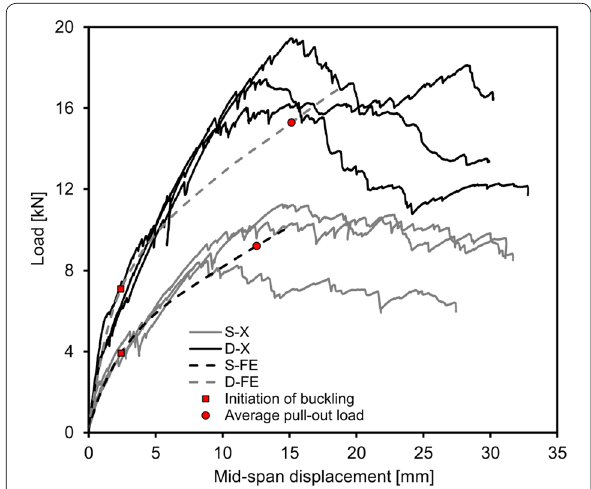
Fig. 17 Comparison of load versus mid-span displacement obtained from the tests (S-X and D-X) and FEA (S-FE and